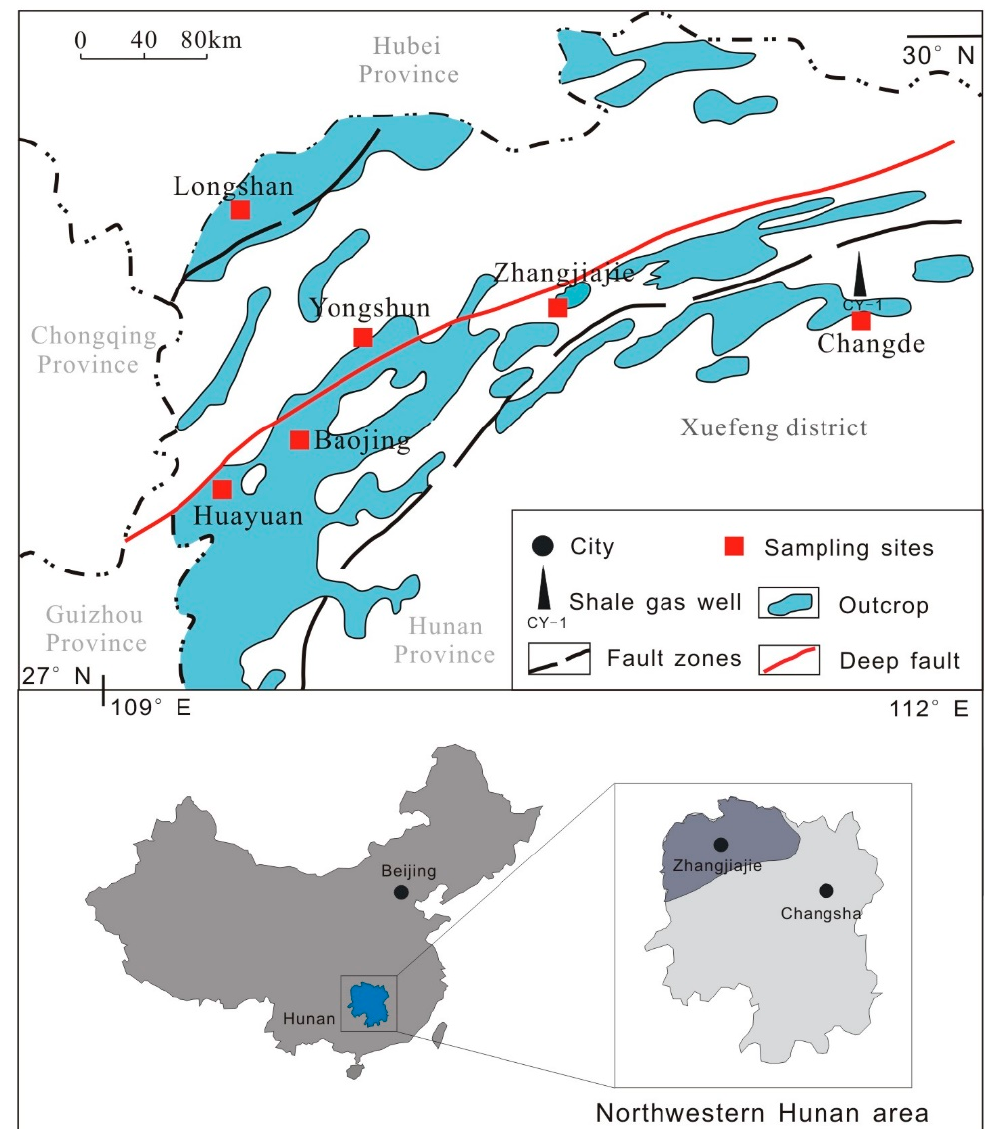
Figure 1. The map of regional structure and outcrop distribution of the marine shale in northwestern Hunan. The coordinates of the shale gas well (CY-1) is (111.725449, 29.186193).